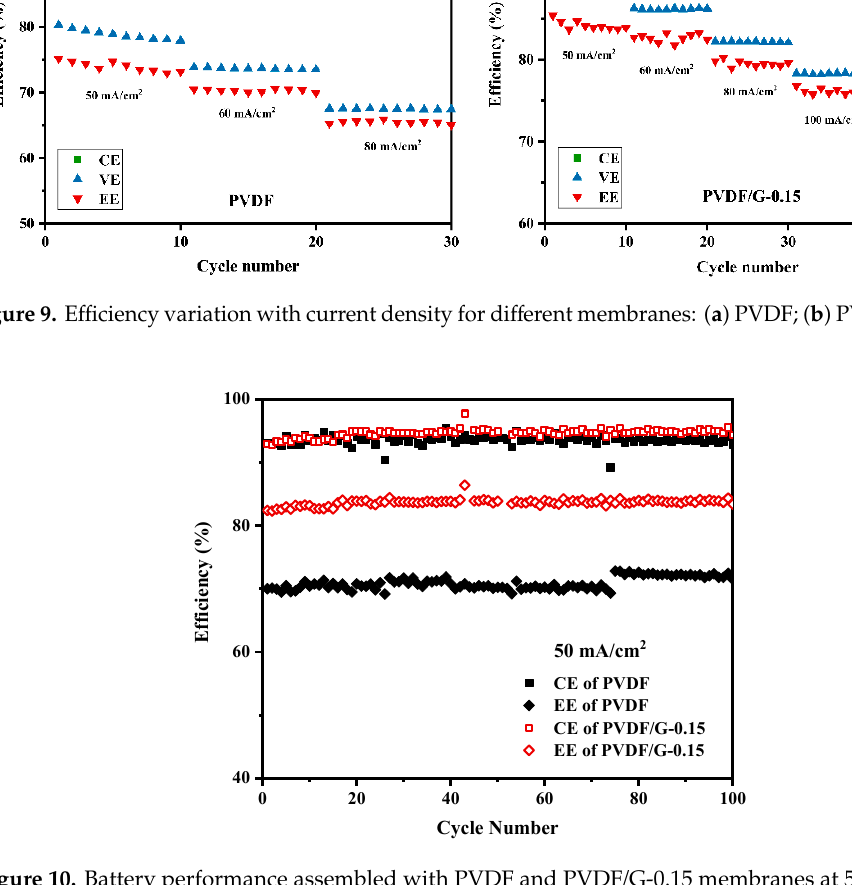
Figure 9. Efficiency variation with current density for different membranes: ( a ) PVDF; ( b ) PVDF/G- 0.15.